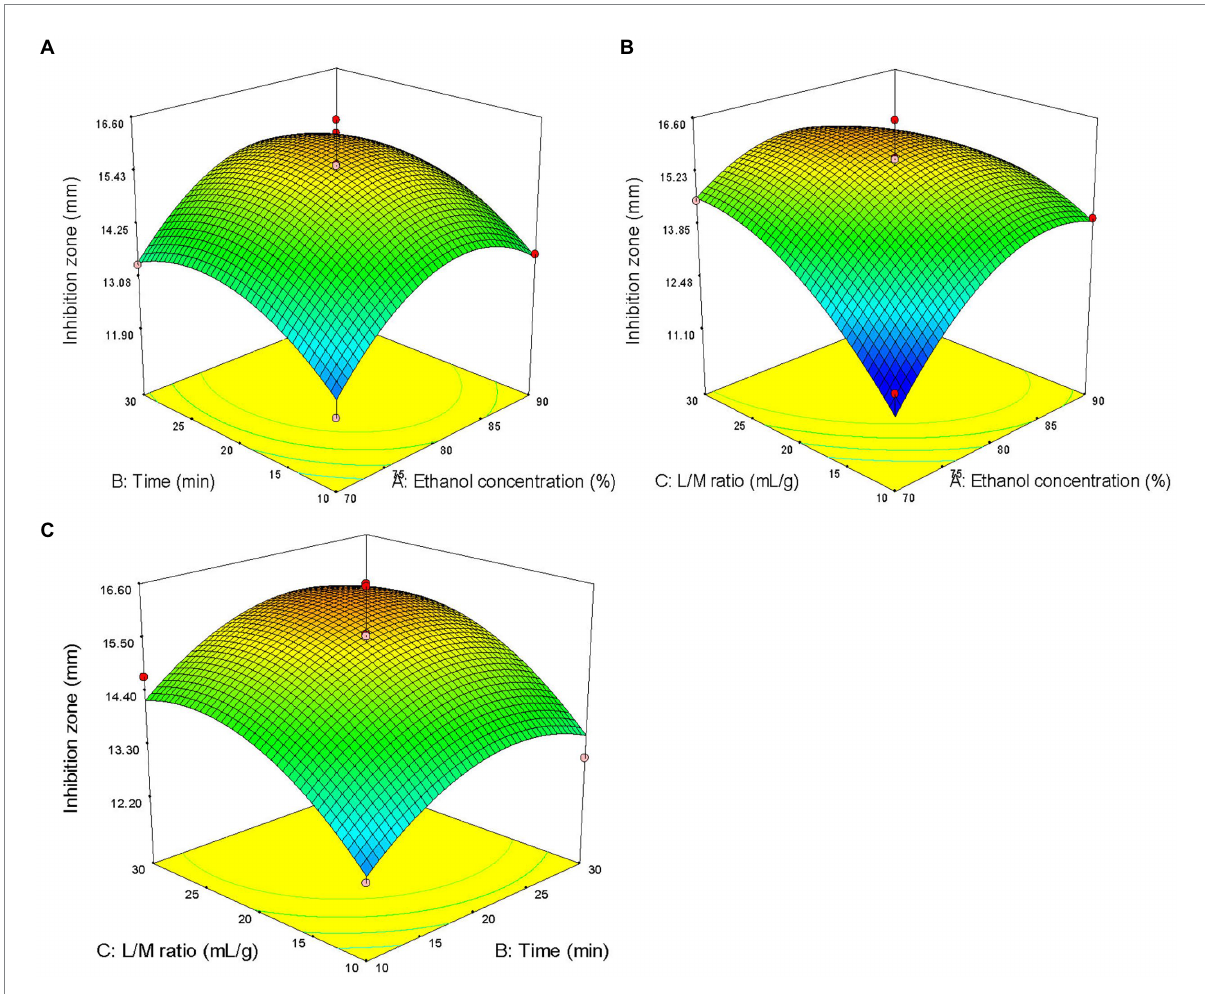
FIGURE 2 Response surface plots showing effects of pairwise factors on the antibacterial activity of the extract and their interaction. (A) Ethanol concentration and time (liquid/solid ratio was constant at 20: 1); (B) Ethanol concentration and liquid/solid ratio (the extraction time was constant at 20 min); and (C) time and liquid/solid ratio (ethanol concentration was constant at